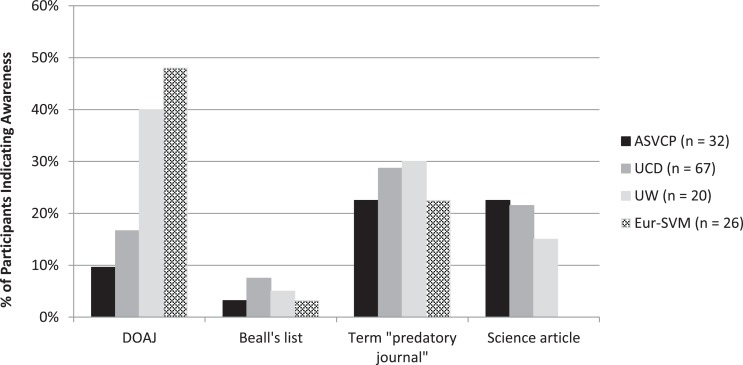
Percentage of respondents indicating awareness of the Directory of Open Access Journals (DOAJ), Beall’s list, the term “predatory journal”, and the Science “sting” article about predatory journals. Results differed significantly (P < 0.03) by site for all questions except awareness of Beall’s list.